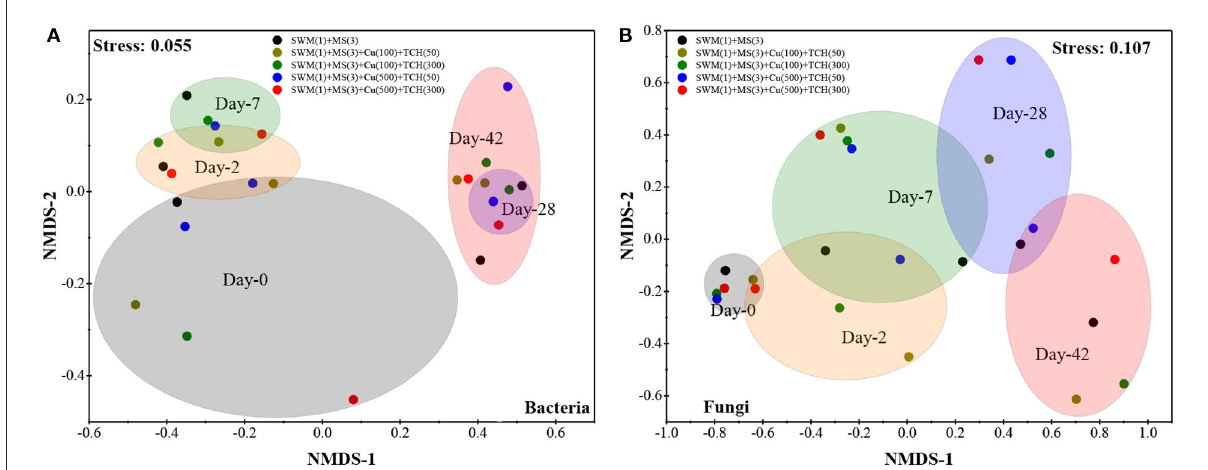
FIGURE3 Non-metric multidimensional scaling (NMDS) analysis in bacterial (A) and fungal (B) communities based on OUTs during the composting process.